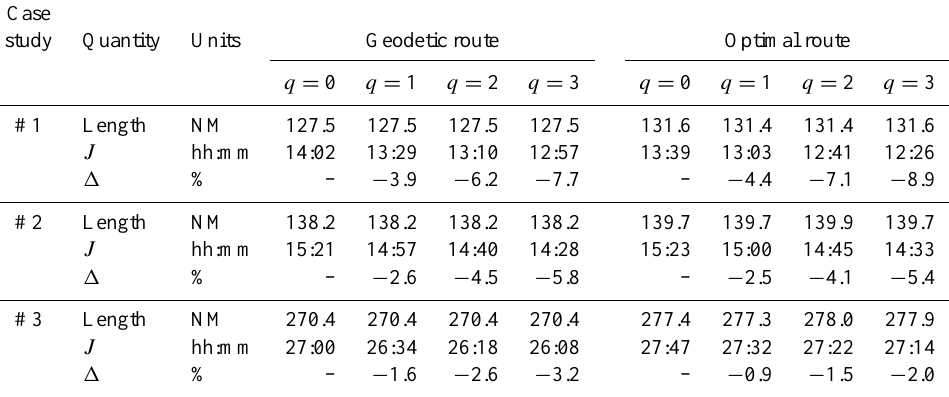
Table B1. Summary metrics for the routes of all case studies in Sect. 3 and different values of q parameter in Eq. (B1). Voluntary speed J(q)/J( 0 ) reduction is allowed. For both the geodetic and the optimal route, (cid:49) 1 is the relative difference in navigation time with respect = − to the case of constant C T (i.e. q =